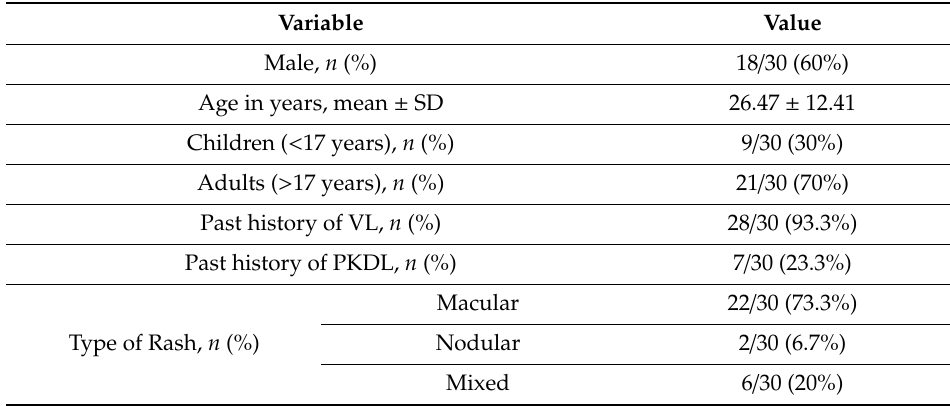
Table 1. Clinical and demographic parameters of the Post-kala-azar leishmaniasis (PKDL) patients enrolled in the study ( n =